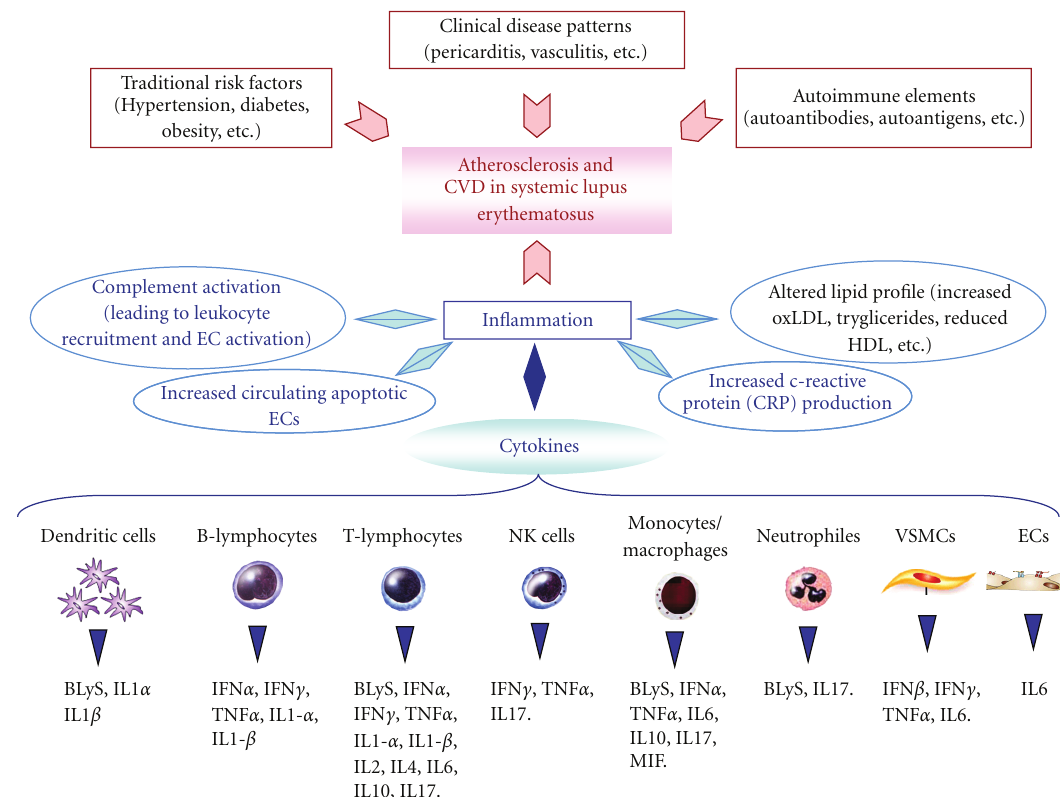
Figure 1: Mechanisms leading to atherogenesis and Cardiovascular disease in SLE patients. ECs: endothelial cells; VSMCs: vascular smooth muscle cells; TNF: tumour necrosis factor; ILs: interleukins; IFN: interferon; BLyS: B lymphocyte stimulator.